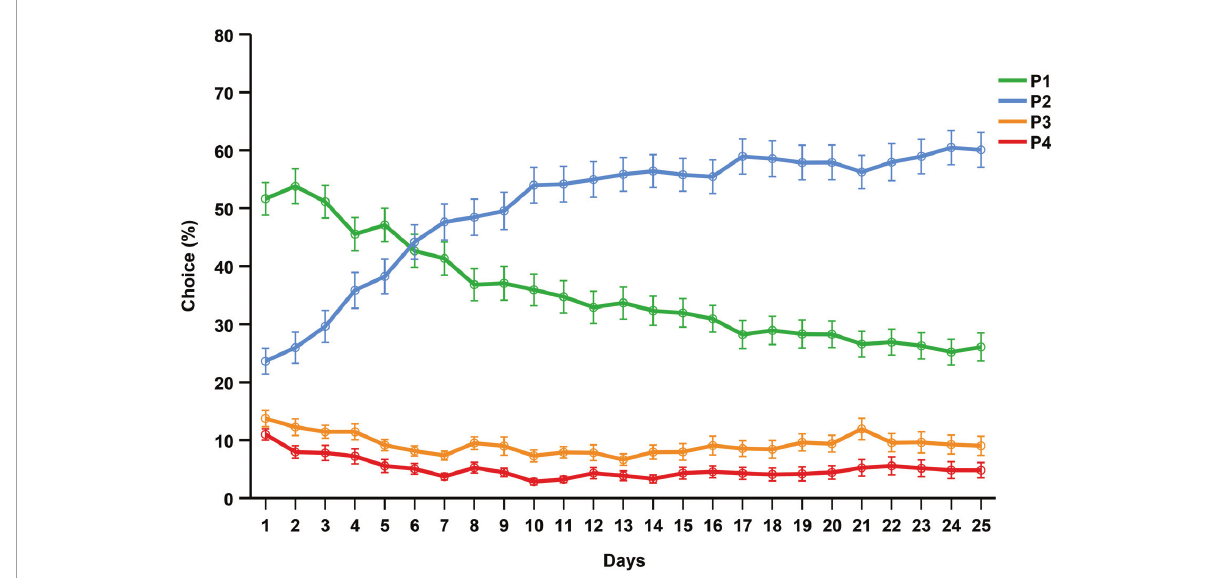
FIGURE4 Average choices (%) for each day that the rGT was performed. Data are presented as mean ± 1 standard error (SE).